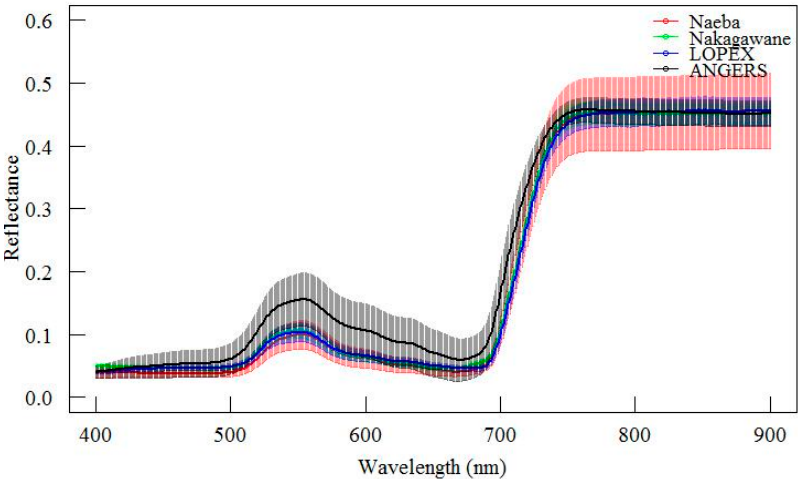
Figure 9. Mean reflectance spectra and standard deviations. Solid lines represent mean reflectance and thinner zones represent standard deviations.